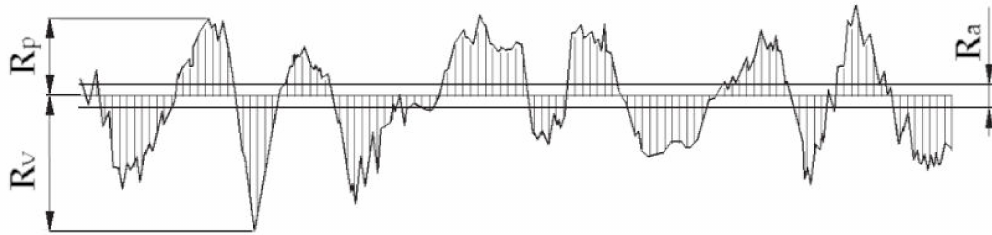
Figure 1. Graphical interpretation of R a , R v , R p parameters inside the elementary